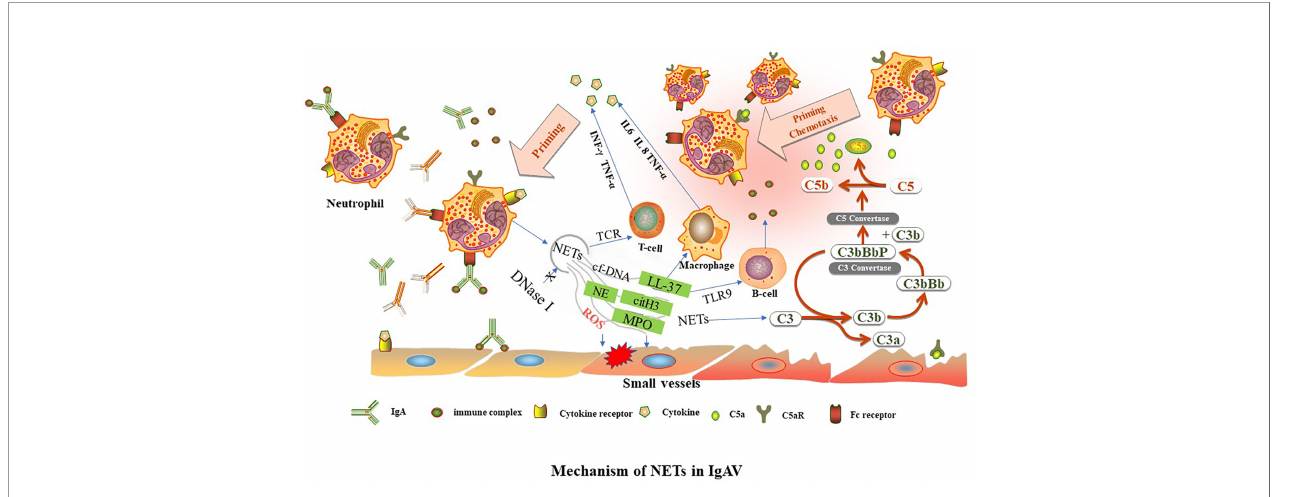
FIGURE 1 | TNF a , tumor necrosis factor alpha. INF- g , interferon gamma. NETs, neutrophil extracellular traps. LL37, cathelicidin antimicrobial peptides. C3, complement factor 3. IL, interleukin, MPO, myeloperoxidase. NE, neutrophil elastase. cit-H3, citrullinated-histone H3. cf-DNA, cell free DNA. TCR, T cell receptor. TLR9, toll-like receptor 9-dependent manner. Aberrant glycosylation of IgA1 and IgA immune complexes (IgA-ICs) induce NETs formation by binding to the Fc receptor of neutrophils. The level of DNase I decreases, leading to reduce of NETs degradation. NETs activate downstream target immune cells to release cytokines. NETs can activate immune-related cells, such as T lymphocytes (through TCR), B lymphocytes (through TLR9-dependent manner) and macrophages to release cytokines, such as IL6, IL 8, TNF- a , and INF- g . NETs are involved in different complement bypass